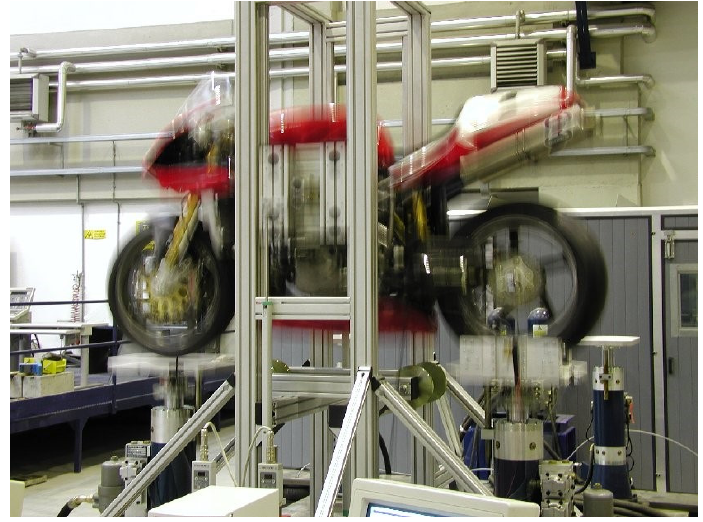
Figure 6. The actual system with a test bike performing a frequency sweep test.